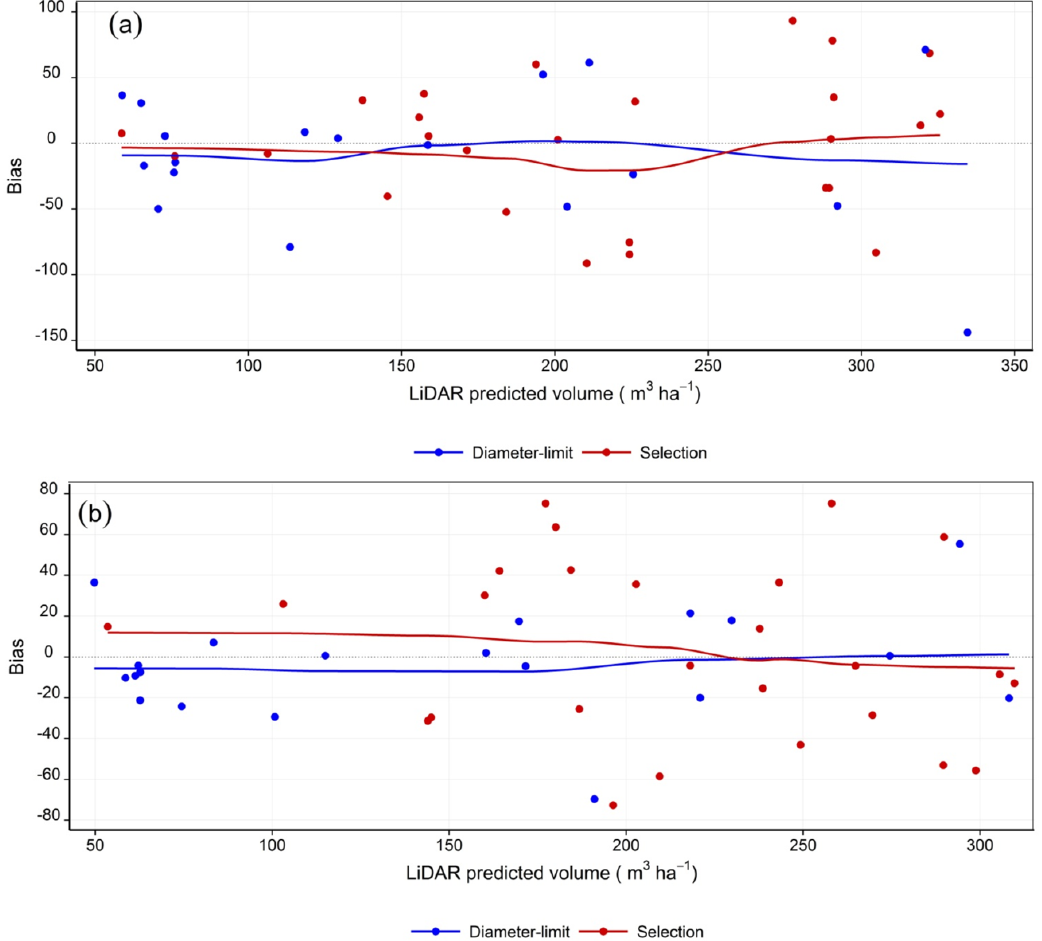
Figure 4. Scatterplot of stem volume prediction bias (observed - predicted; m 3 ha −1 ) over LiDAR predicted values with Lowess regression splines for the two silvicultural treatments. The volume prediction model was calibrated based on the 44 operational-grade plot data ( a ); and the 44 research-grade plot data ( b ).